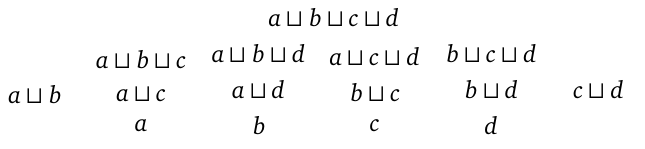
Figure 1: Boolean semi-lattice closed under